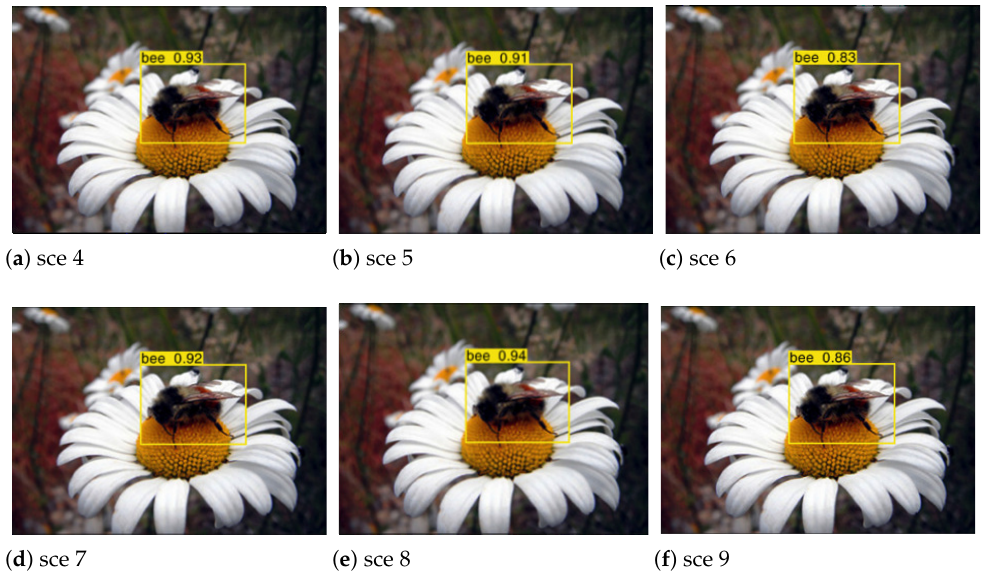
Figure 21. Illustration of object recognition for Scenarios 4–9.